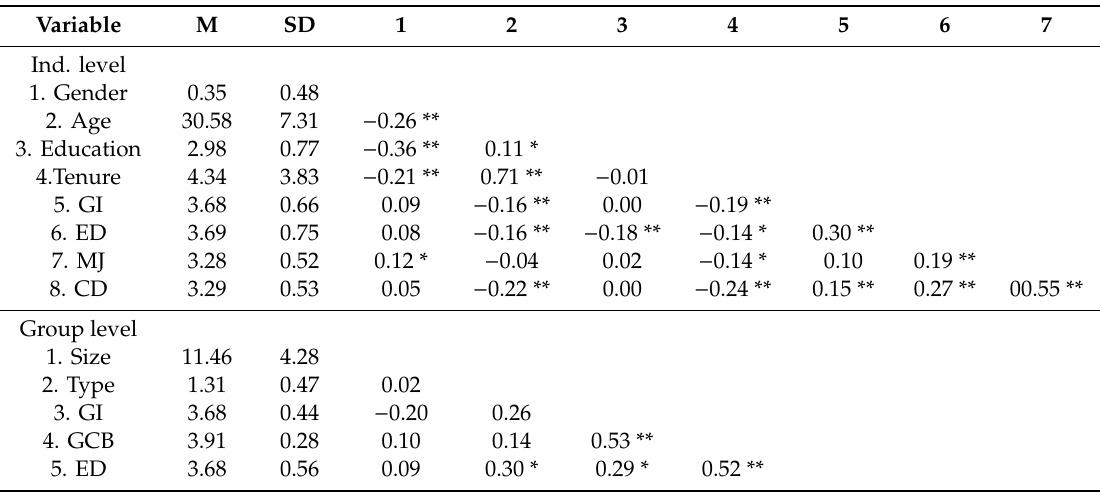
Table 3. Descriptive statistics of